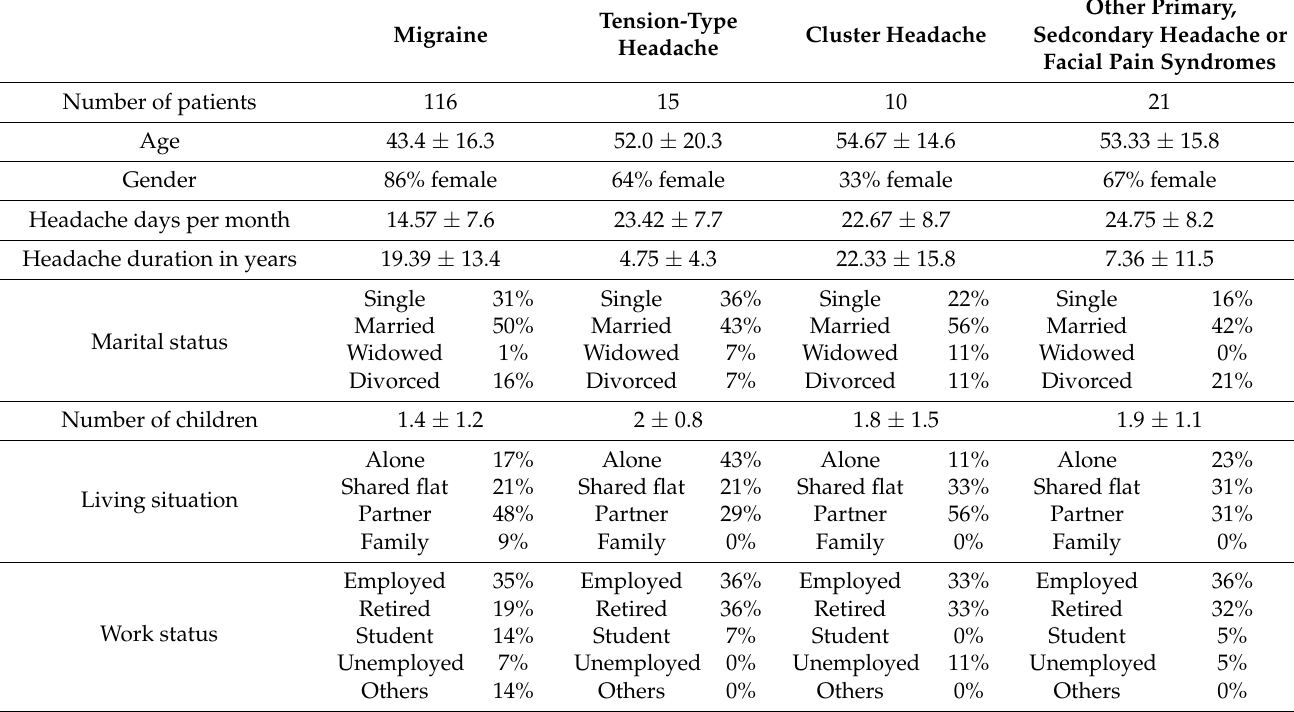
Table 1. Sociodemographic and headache characteristics of first-time consultations grouped by their headache diagnosis. The vast majority of patients was diagnosed with a migraine. Migraineurs tended to be younger than patients with other primary or secondary headache disorders, however, standard deviations are large and indicate a heterogeneous patient population. The frequency of students among migraineurs was larger than in other headache disorders, which probably explains the lower rate of children. Other sociodemographic characteristics were comparable between groups. Missing values are due to missing data, i.e., patients did not wish to disclose that information to their treating